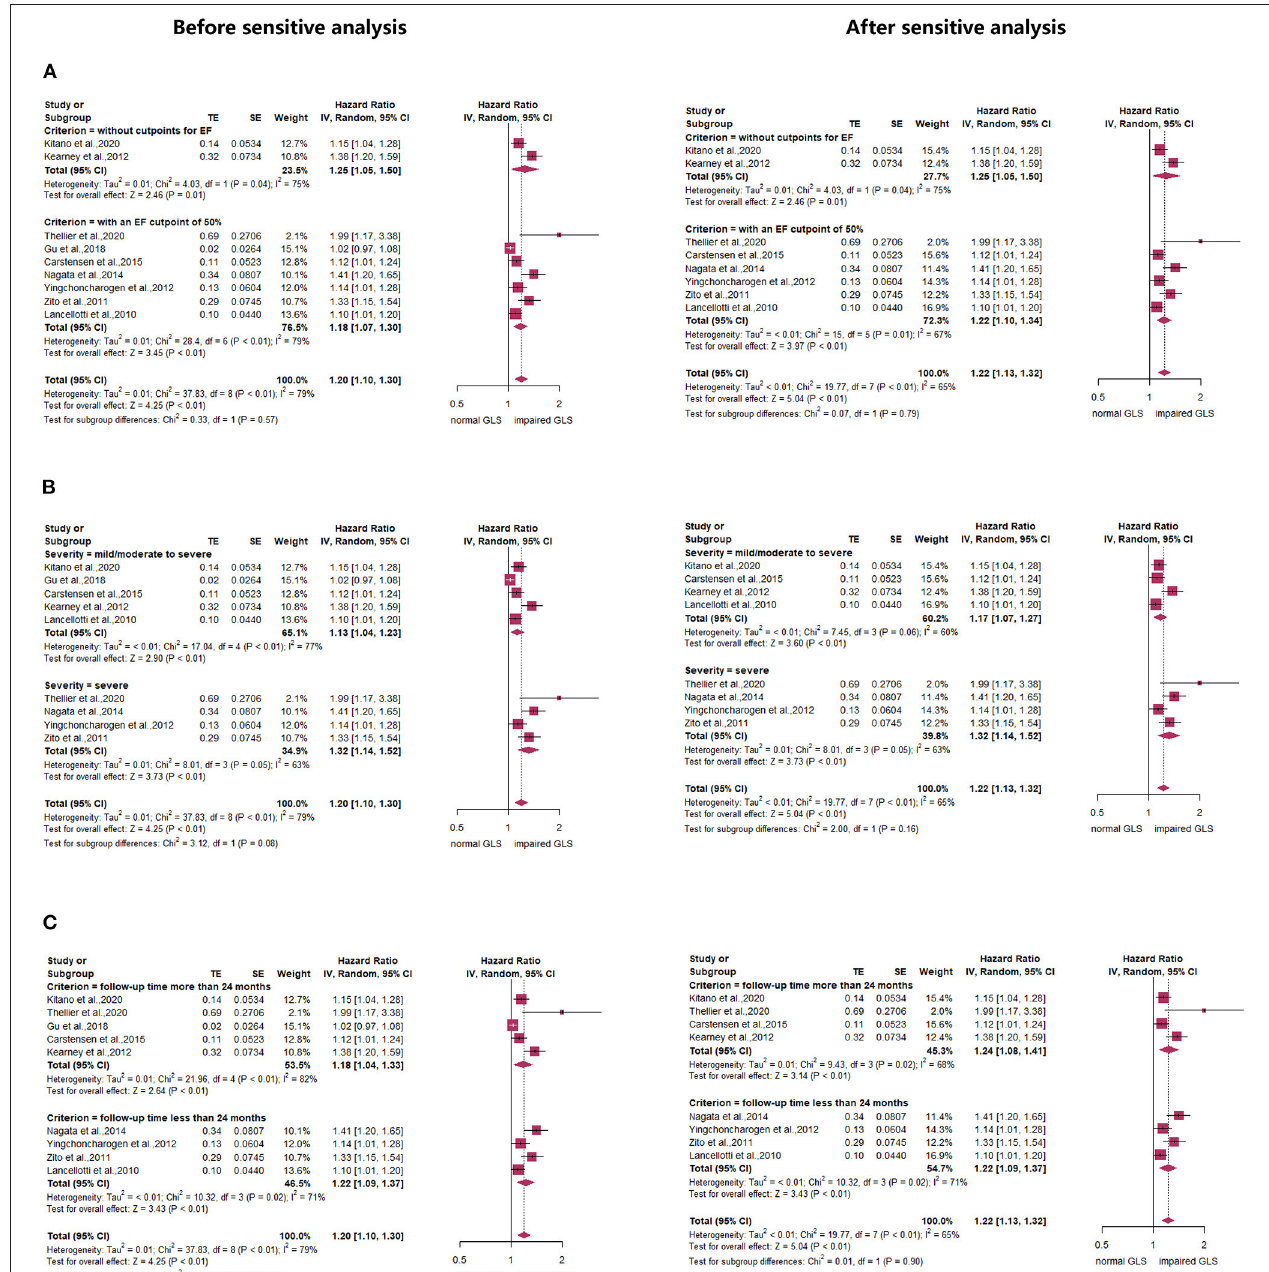
FIGURE 3 | Forest plot demonstrating the association between impaired GLS and MACE defined by (A) ejection fraction (EF) or (B) aortic stenosis (AS) severity or (C) follow-up time.